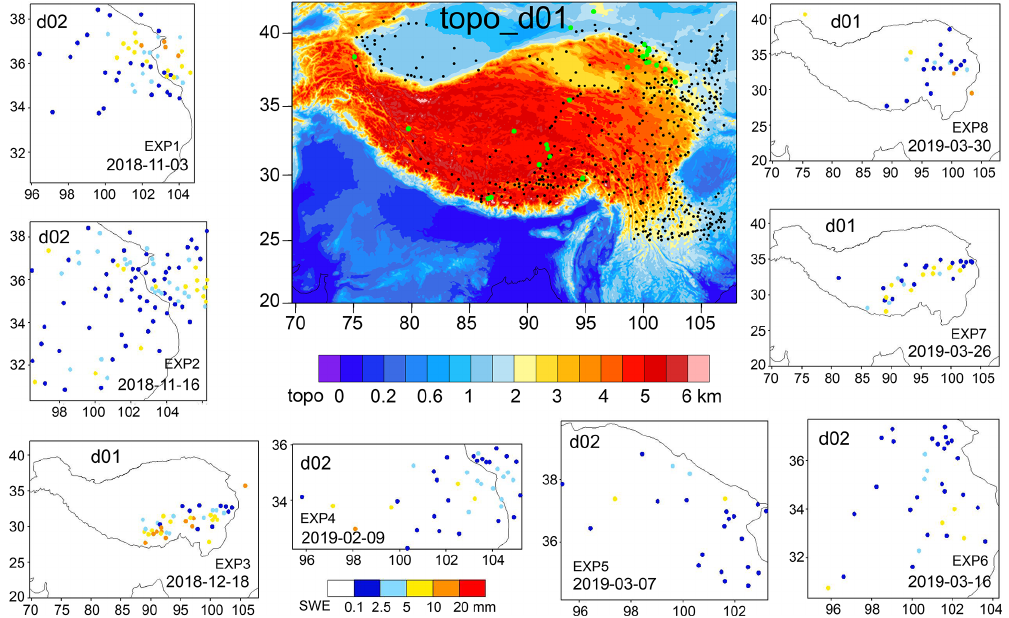
Figure 1. WRF domains of d01 and d02 and CMA observations of daily snowfall amount in colored solid circles for the eight experiments. The topographical height of d01 is shaded with black solid circles indicating the locations of the CMA stations and green solid circles indicating the locations of the CAS stations and the Qilian Mountains integrated observatory